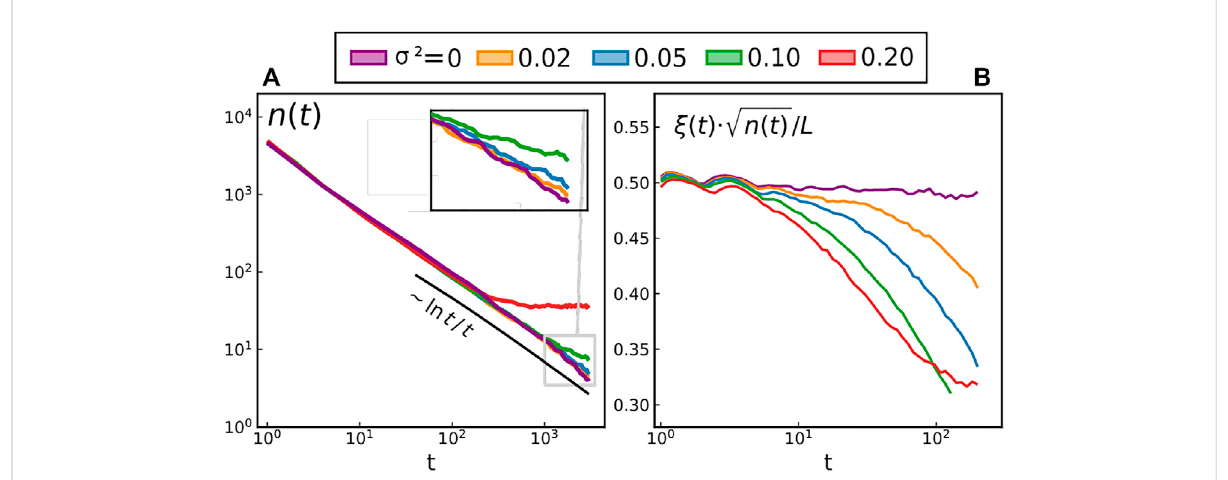
FIGURE 4 Time evolution of (A) the total number of defects n for different forcing intensities and T = 0.4 (B) the quantity ξ density. Note that because the defects are homogeneously distributed, 1/